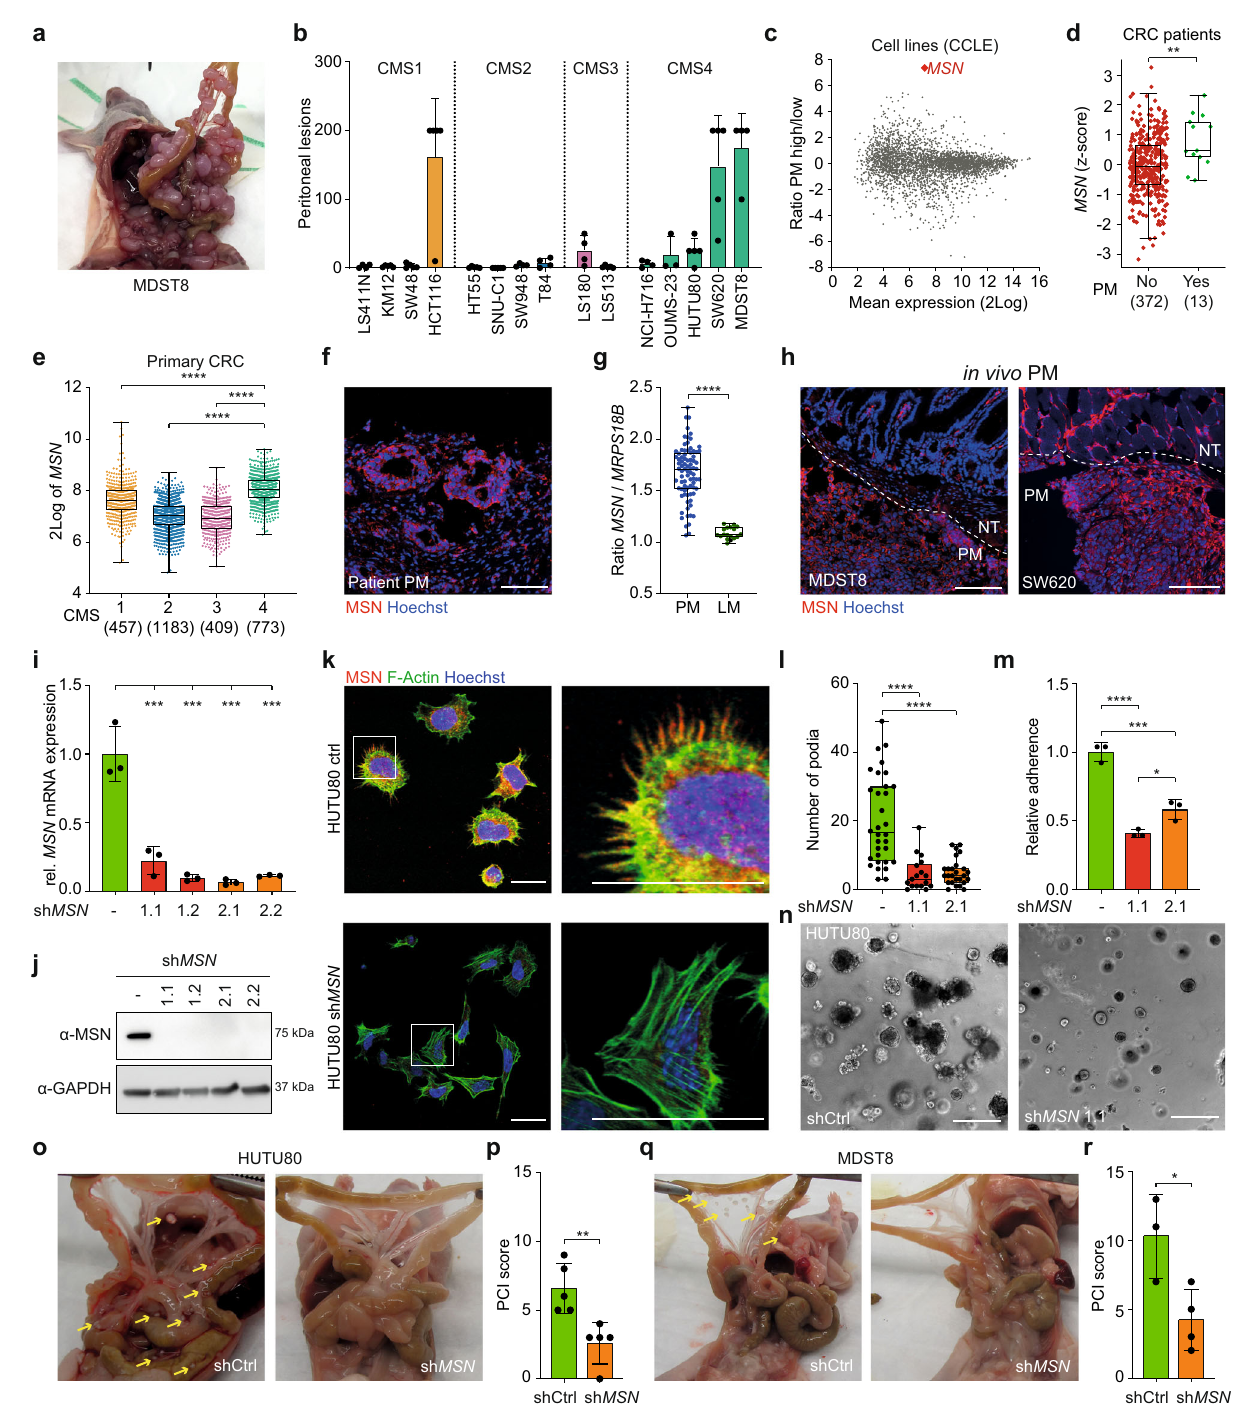
Fig. 5e). Gene expression of inhibitory molecules including PD-1 , PD-L1 , CTLA4 , TIM-3 , or TIGIT was upregulated in CMS4-PM.C (in fl amed sub- type)samples,suggestinganimmunosuppressivemicroenvironmentin these tumors (Fig. 3g). Clinically, patients with CMS4-PM.B lesions presented with higher PCI scores (Fig. 3h and Supplementary Data 6), and a worse OS com- pared to the other 2 clusters combined ( P = 0.006) (Fig. 3i). Peritoneal metastases recapitulate primary CRC phenotype and composition Peritoneal metastasesdevelop at the peritoneal surface following the seedingofCRCcells.Incontrasttometastasesinvisceralorgans,